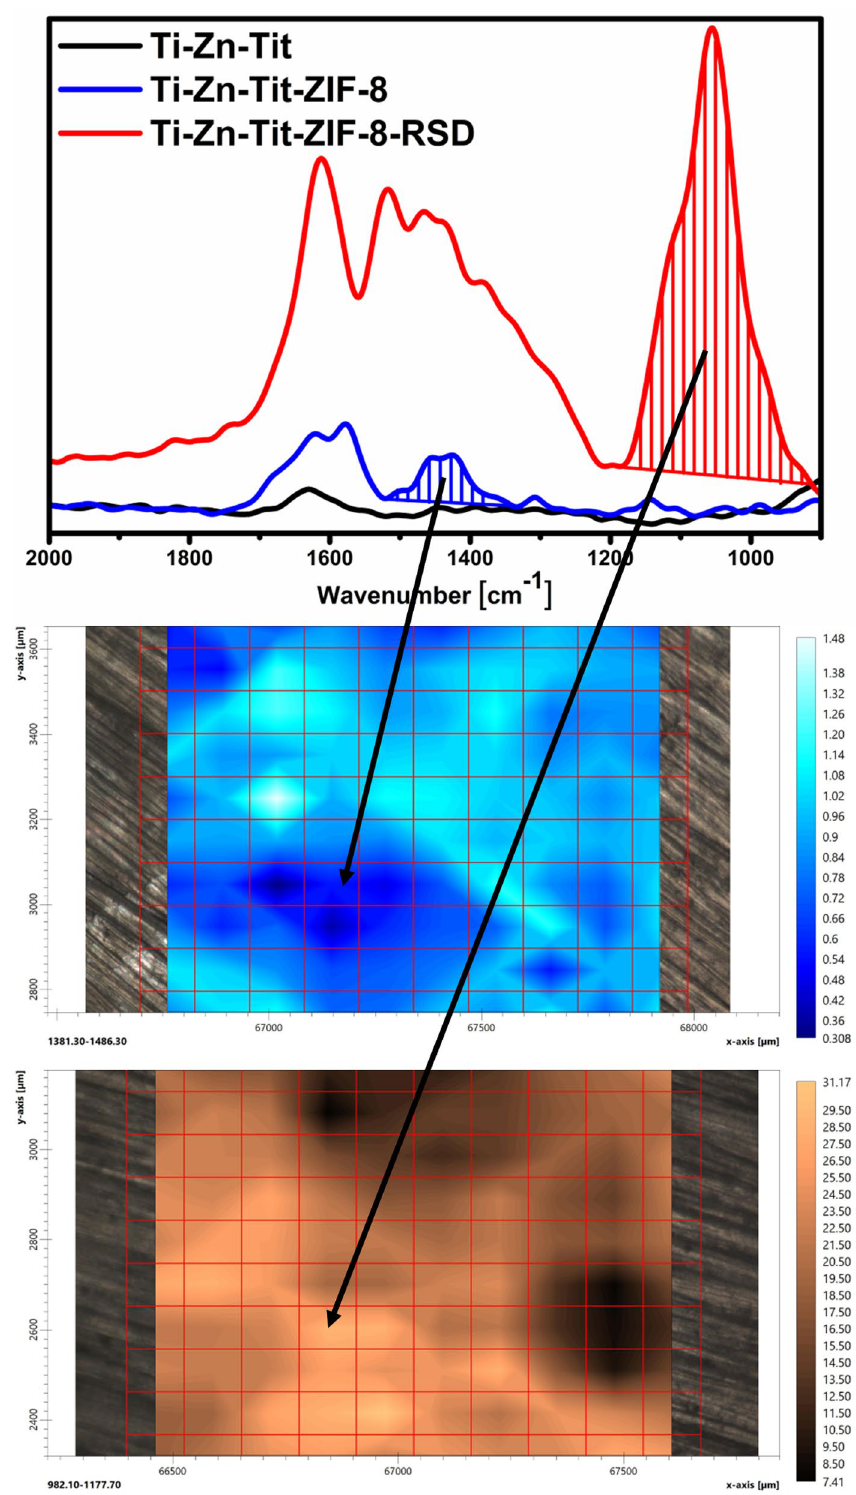
Figure 6. ZIF-8 layer and risedronate distribution using FT-IR imaging, and band for which the images were prepared